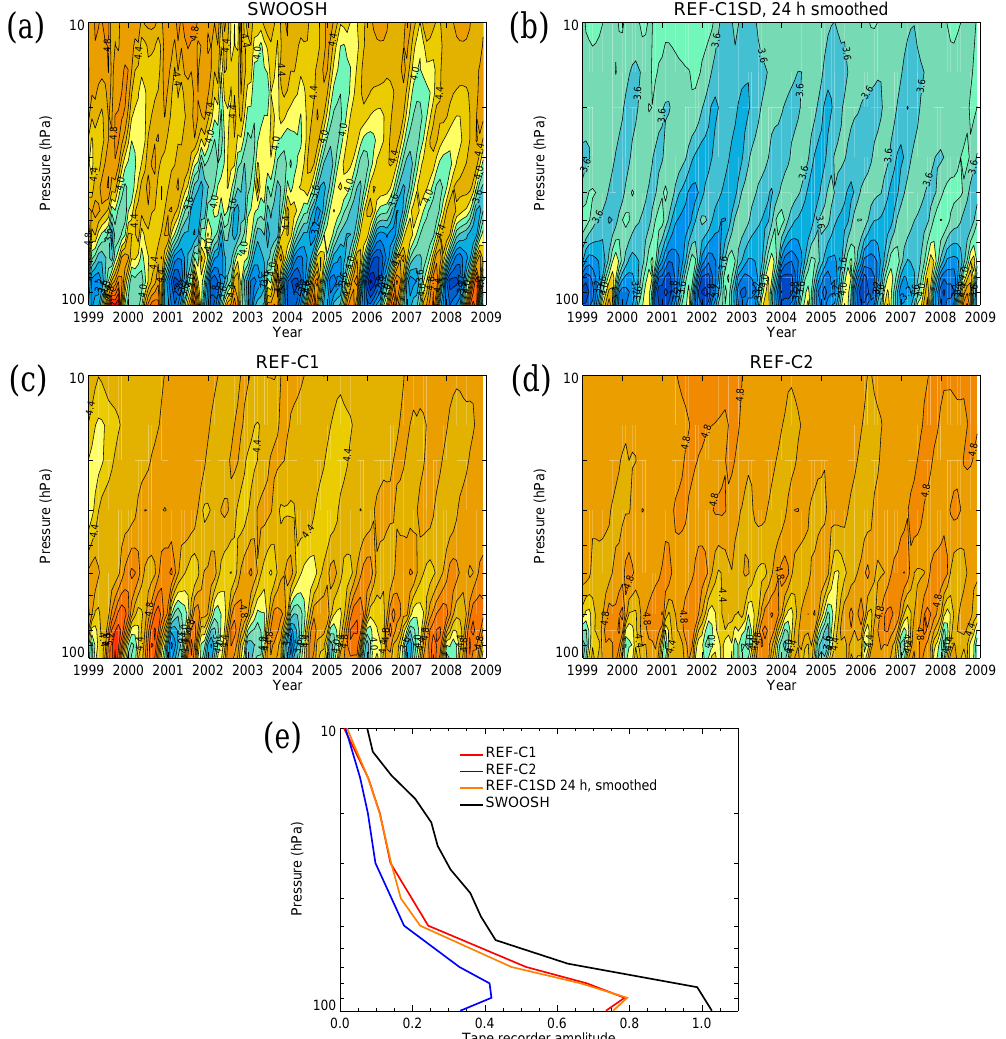
Figure 8. Tropical tape recorder signal, q (ppmv) averaged 10 ◦ S–10 ◦ N, for (a) SWOOSH data, and the (b) REF-C1SD 24h smoothed, (c) REF-C1, and (d) REF-C2 simulations. (e) Amplitude of tape recorder calculated, at each height, as the amplitude of the Fourier harmonic corresponding to the annual